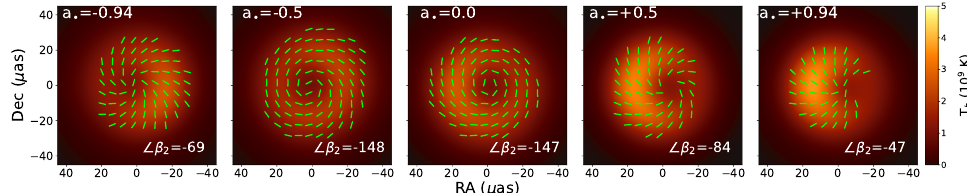
Figure 2. Time-averaged polarimetric images of M87* GRMHD models with increasing spin from left to right, a • ∈ {− 0.94, − 0.5,0,0.5,0.94 } reproduced from Emami et al. [59], using models presented in Event Horizon Telescope Collaboration et al. [32]. The morphology of these linear polarization ticks originates from an evolving magnetic field structure as a function of spin. Models with higher spin have more toroidal magnetic fields due to frame dragging, which leads to a more radial polarization pattern, while the opposite is true for a • ∼ 0. This is reflected in ∠ β 2 , written in degrees at the bottom of each panel, which is closer to − 180 ◦ for toroidal patterns like the a • = 0 model, but moves towards 0 ◦ for more radial patterns like the a • = 0.94 model [58].